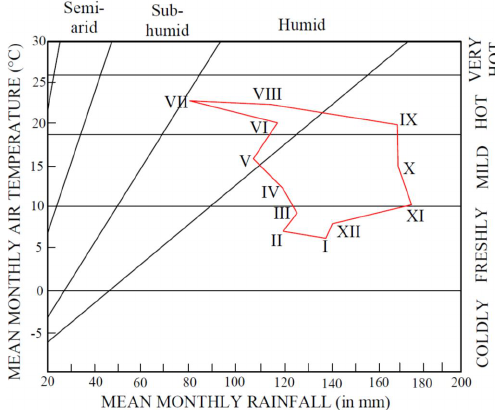
Figure 5. Foster diagram for Rijeka City,